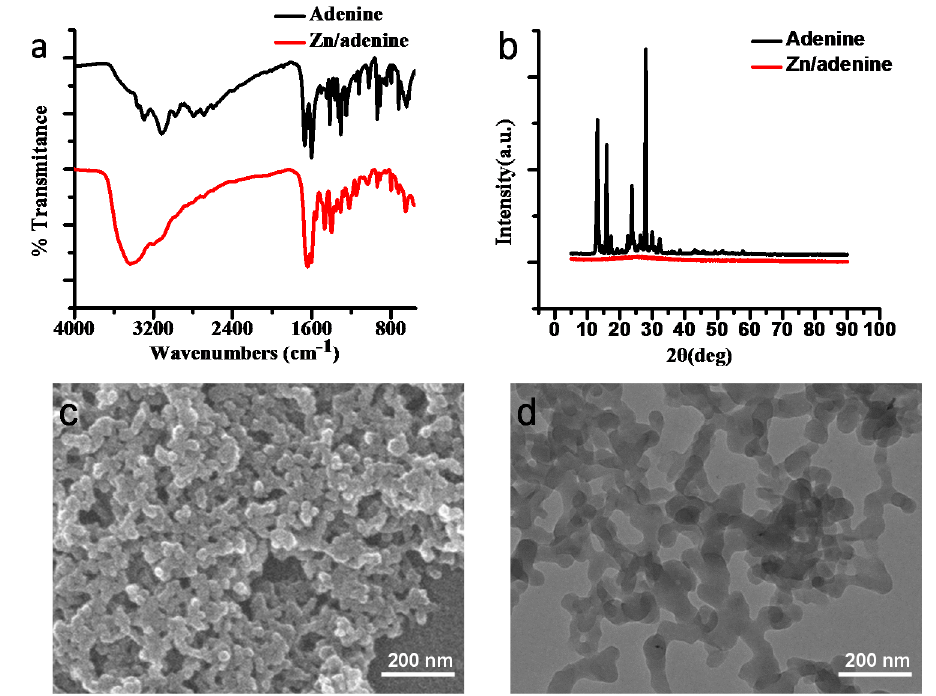
Figure 1. ( a ) The fourier transform infrared spectroscopy (FTIR) spectra of adenine and Zn/adenine complexes; ( b ) X ‐ ray diffraction (XRD) patterns of powdery adenine and Zn/adenine complexes; ( c ) Scanning electron microscopy (SEM) image of Zn/adenine complexes (magnification = 30,000); ( d ) Transmission electron microscopy (TEM) image of Zn/adenine complexes.